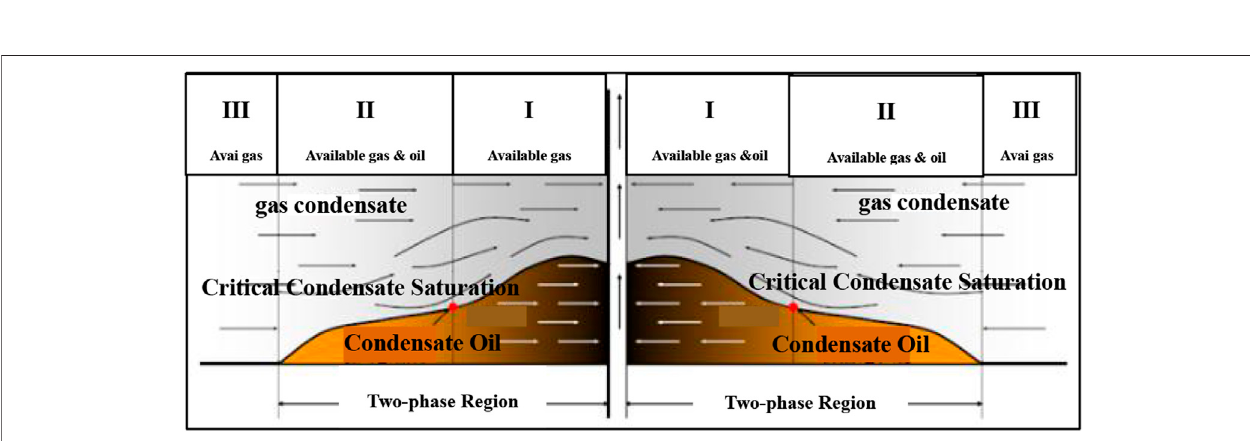
Frontiers in Earth Science |